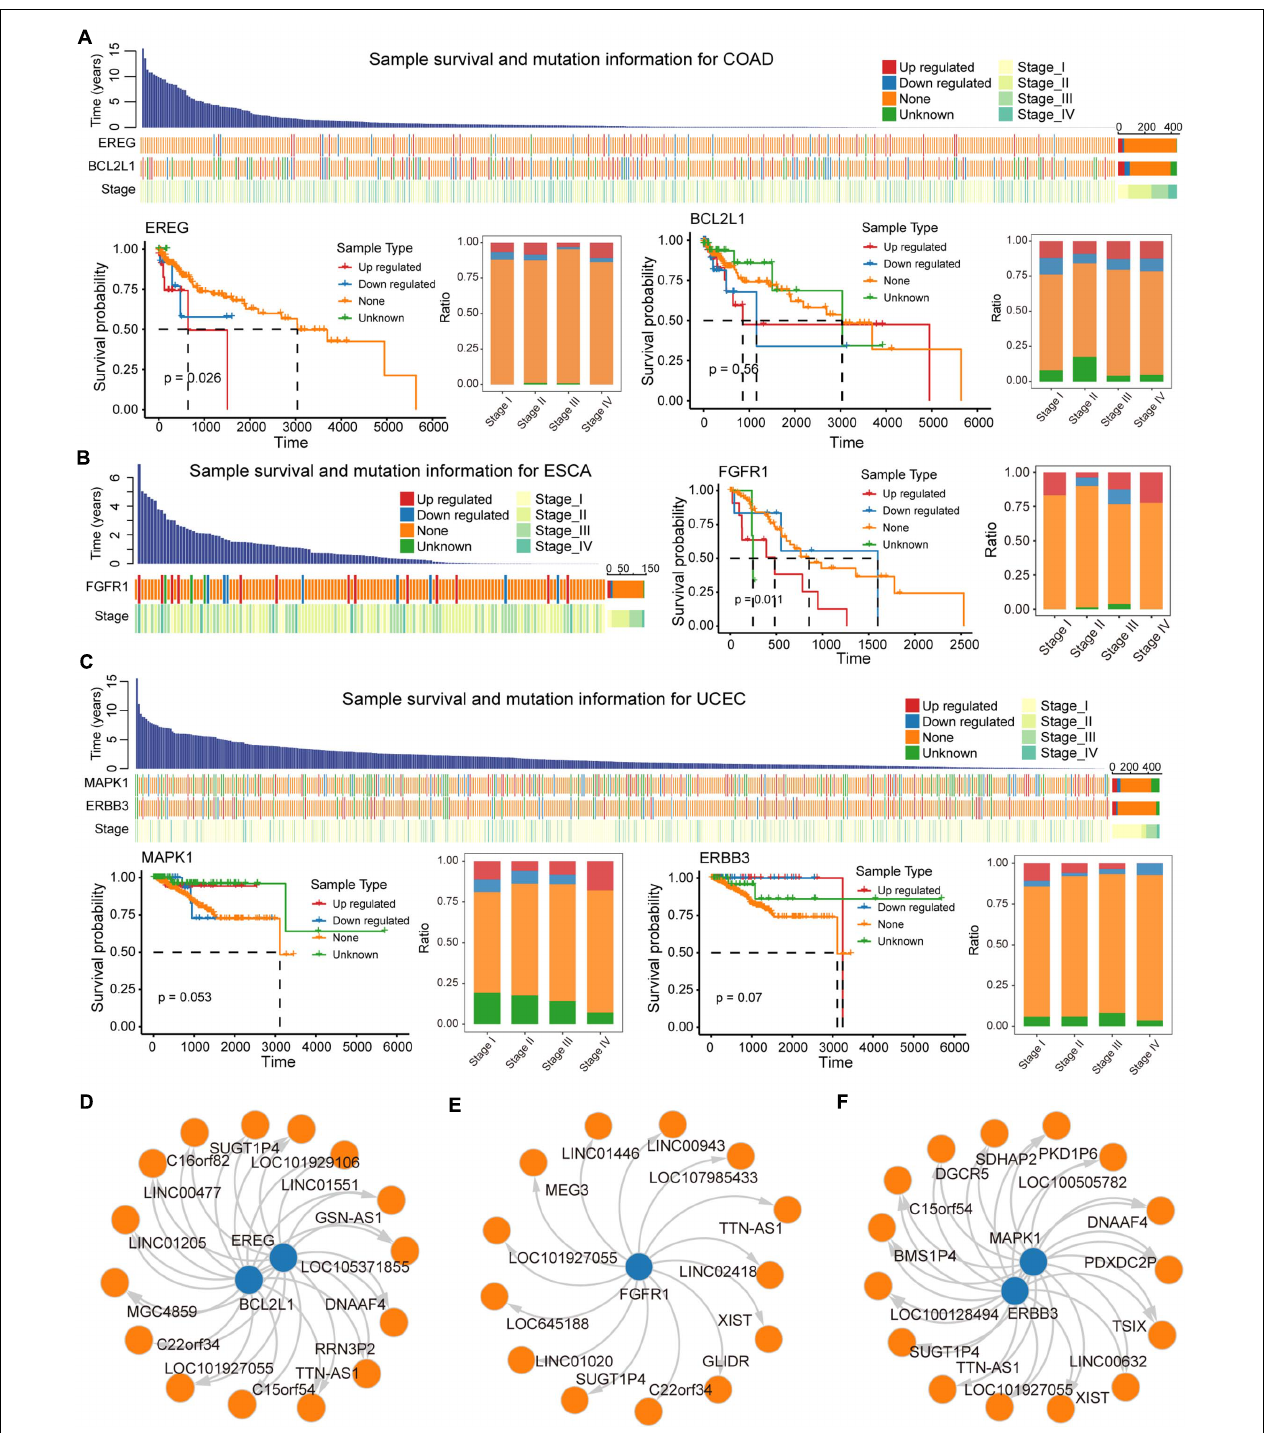
FIGURE 6 | Biomarker lncRNAs (ceL) regulate mRNA (ceM) through the ceRNA mechanism. (A) Waterfall plot illustrating effects (Up-regulated, Down-regulate, None, and Unknown) of mutations in each sample for COAD on ceM expression, and include information such as patient survival time and clinical stage of each sample. Survival predictions and relationships to clinical staging for four sample types classified, respectively, based on the genes EREG and BCL2L1 were presented by survival curves and bar plot. (B) Same as in (A) but for ESCA, and the gene FGFR1. (C) The same as in (A) but for UCEC, and the genes MAPK1 and ERBB3. (D–F) The relationship between biomarker lncRNAs and regulated ceM for COAD, ESCA, and UCEC.